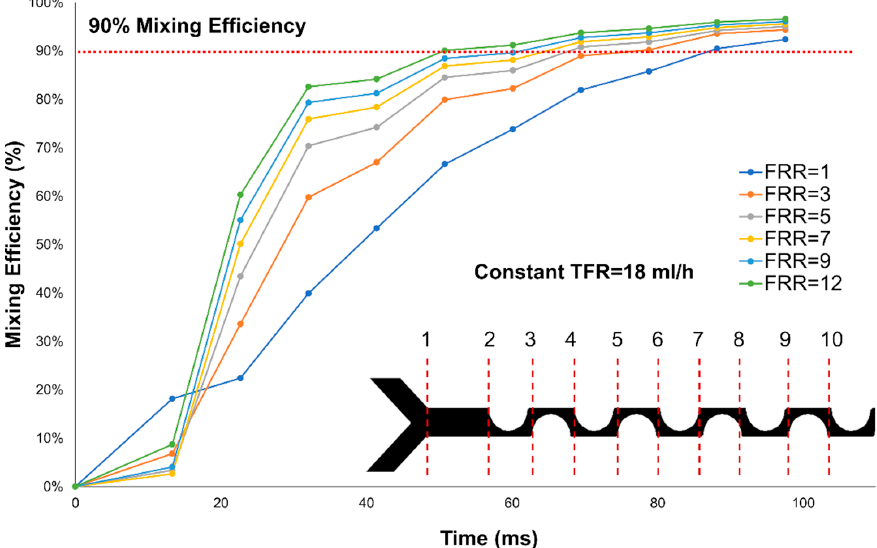
Figure 8. Mixing efficiency at different FRRs. Each data point corresponds to a cross ‐ section for a total Figure 8. Mixing e ffi ciency at di ff erent FRRs. Each data point corresponds to a cross-section for a total of 10 data points from 1–10. of 10 data points from